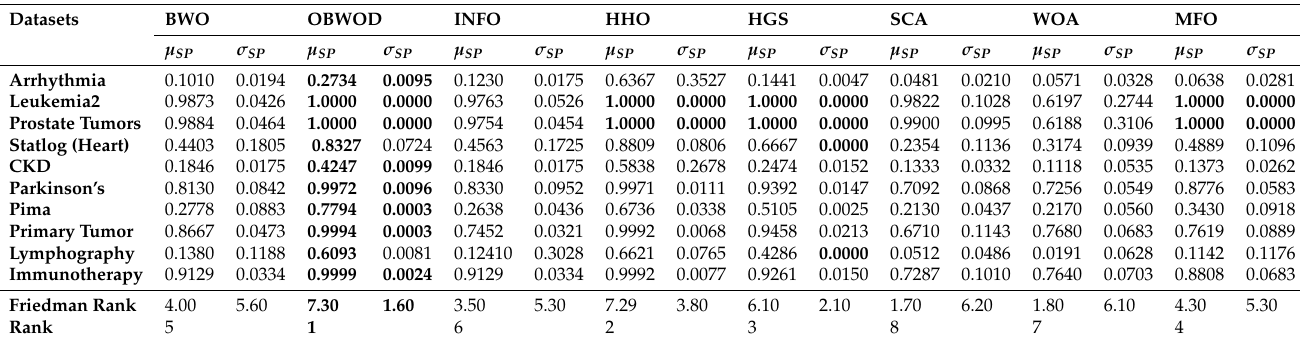
Table 11. Comparison of the specificity between OBWOD and other optimization algorithms based on the kNN